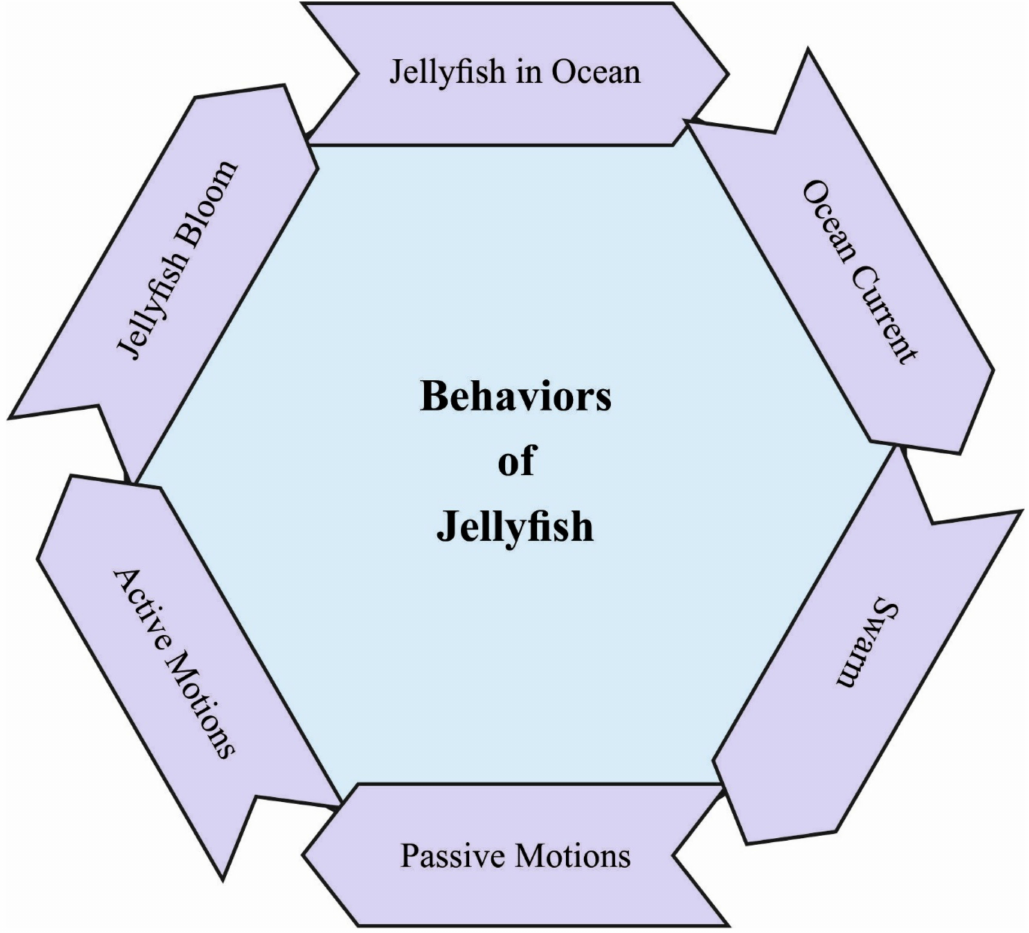
Figure 3. Behaviors of